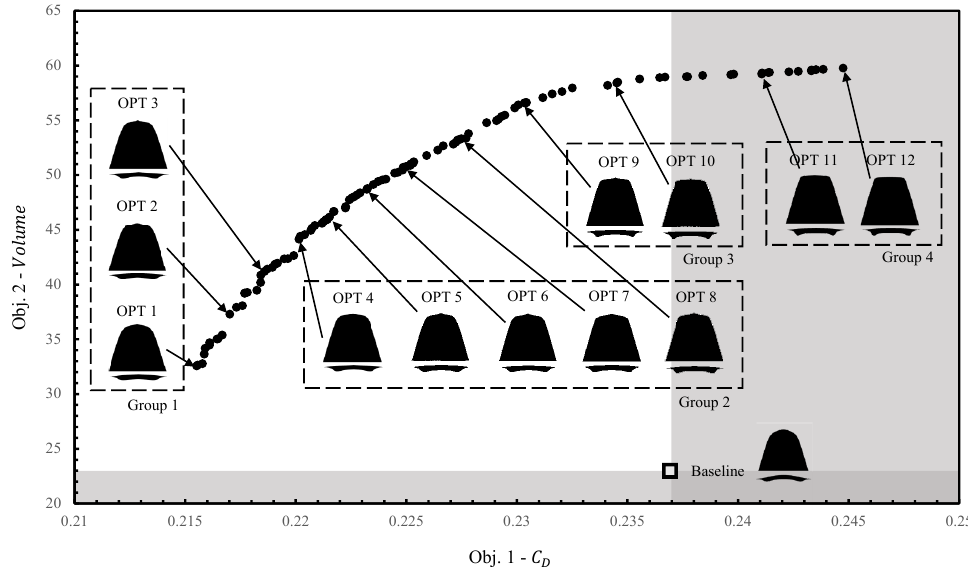
Figure 12. Optimal points and Pareto front estimated by kriging model. Table 3. Design variables and geometric constraint for representative optimal solutions.